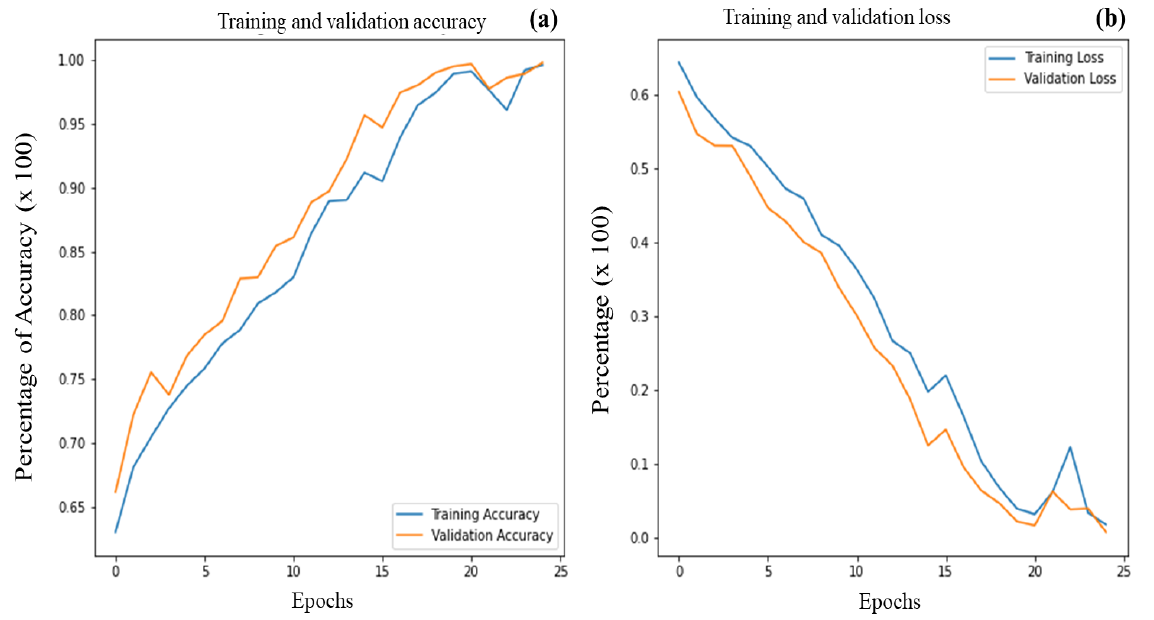
Figure 16. ( a ) Accuracy and ( b ) validation loss for single-lead.